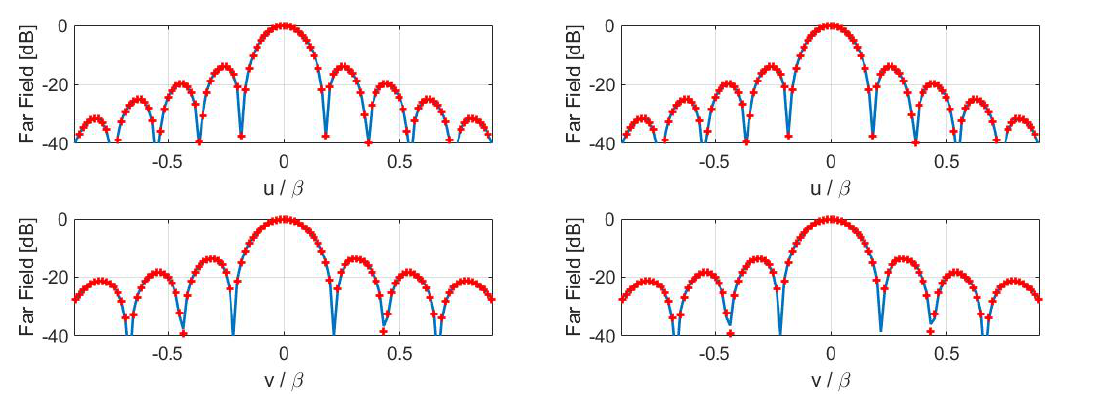
Figure 13. Case B—Cuts, along the u and v planes, of the reference (red pluses) and retrieved (blue solid line) FFP. ( Left ) Shannon number. ( Right ) mutual information.